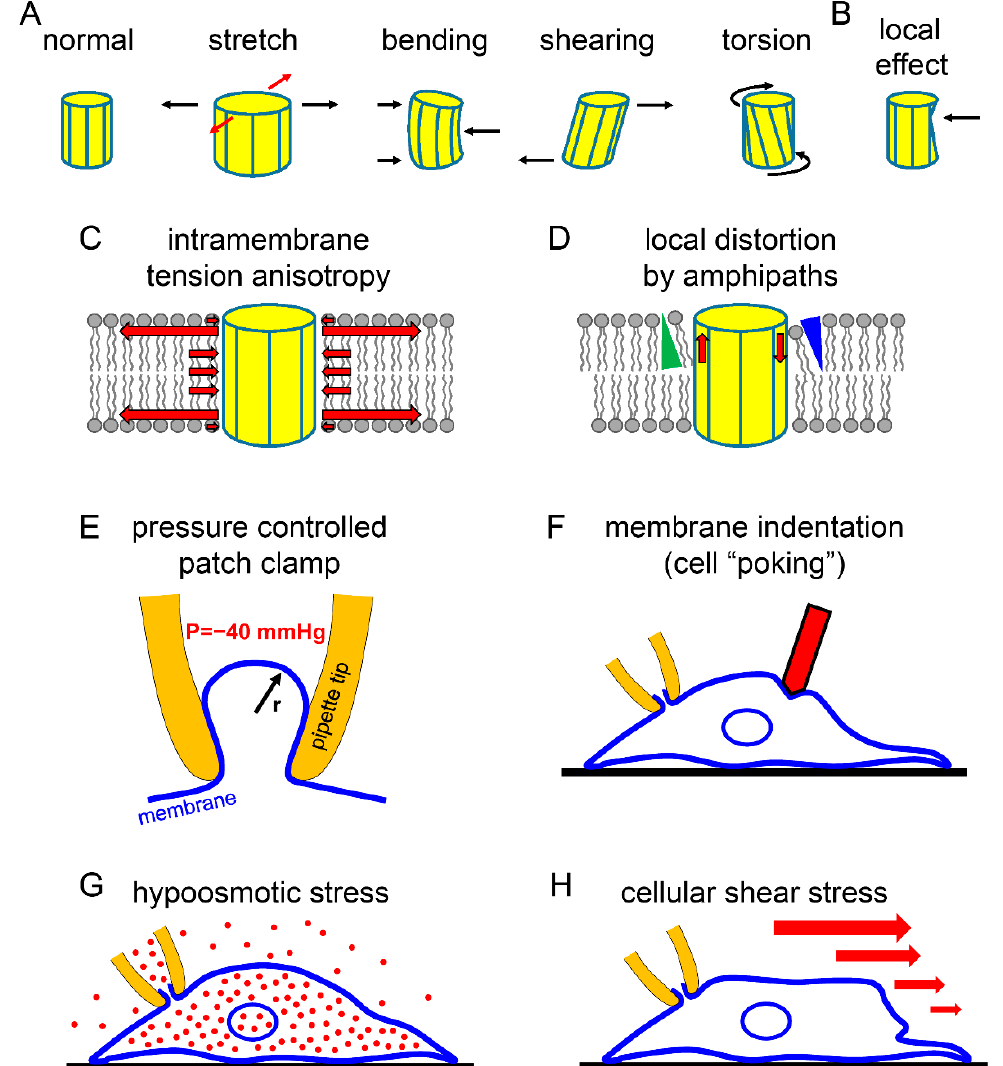
Figure 2. Global and local mechanical effects may influence the ion channel proteins, and the generally used methods to study mechanosensitive ion channels induce membrane tension (stretch) with a not particularly well-defined combination of the other effects. ( A ) Possible global mechanical effects have the potential to influence the whole channel protein complex. ( B ) The force may be transmitted to the channel protein through a specific molecular determinant as a local effect. ( C ) Tension is not uniformly distributed within the structure of the phospholipid bilayer, but is mostly concentrated to two thin layers within the two leaflets. ( D ) The insertion of conical shaped amphipaths into the bilayer may induce a substantial membrane bending effect, change relative thickness of the membrane, or induce local forces acting on the channel protein. Amphipaths may be incorporated into the inner or outer leaflet. ( E ) The pressure gradient between the two sides of the cell-attached or excised membrane patch ( p = − 40 mmHg in the illustration) induces tension, depending on the radius of curvature (r). ( F ) The membrane indentation with a blunt probe (red) imitates the physiological local mechanical effect during a whole-cell patch clamp measurement. ( G ) Cellular swelling in hypotonic environment stretches the plasma membrane. ( H ) The fluid stream causes shear stress of a cell attached to solid